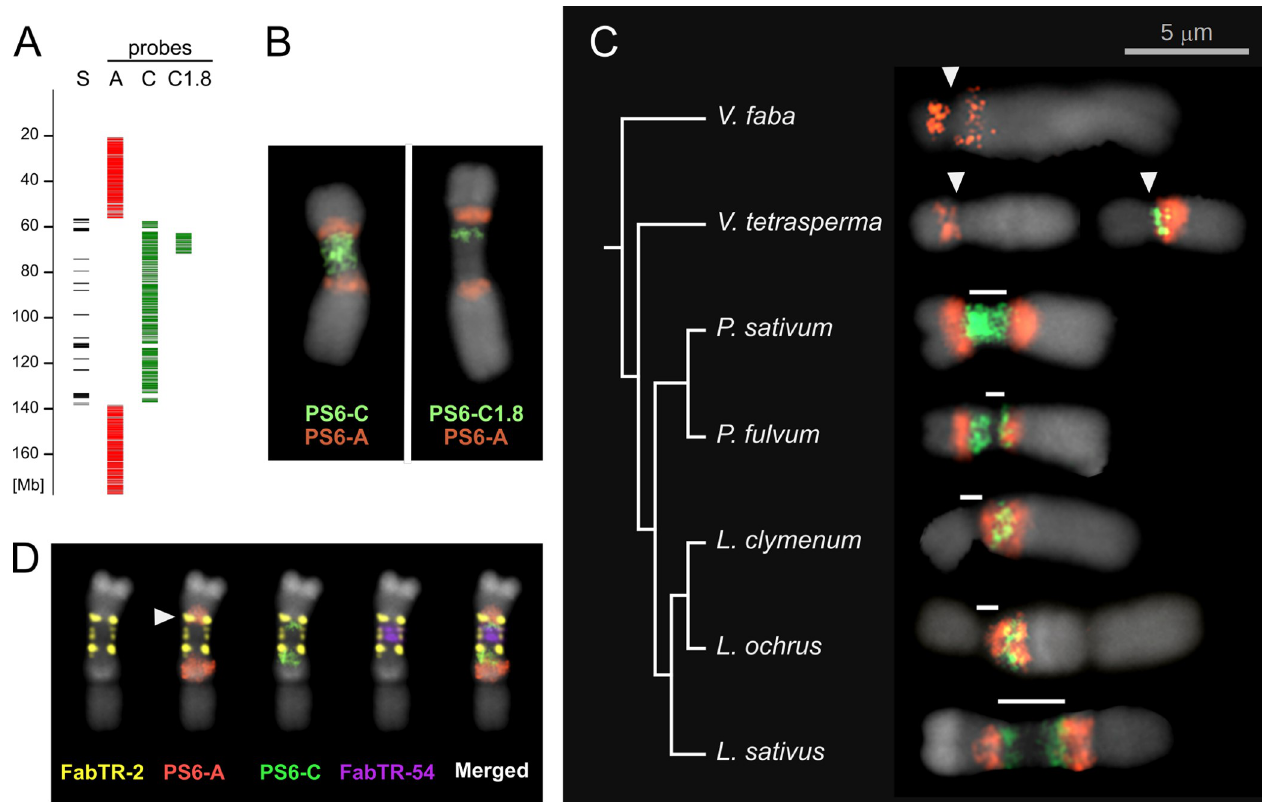
Fig 5. CEN6 painting probes and their application for the detection of orthologous regions in related species. (A) Positions in the assembly of oligonucleotide sequences used as FISH painting probes. Each column represents different PS6 probes. Column “S” shows the positions of satDNA arrays marking the extent of primary constriction. (B) Painting probes applied to P . sativum chromosome 6. (C) FISH analysis of a set of related Fabeae species using PS6-C (green) and PS6-A (red) probes. The phylogenetic tree was adapted from [20]. Only chromosome(s) that produced hybridization signals are shown. Primary constrictions are marked with white arrowheads (monocentric) or bars (metapolycentric chromosomes). Images of whole chromosome complements can be found in S5A Fig. (D) Multicolor FISH labeling of the Lathyrus sativus homeolog of pea chromosome 6 using PS6 painting probes as well as probes for satellite repeats FabTR-54, which fills the gap in the PS6-C signal, and FabTR-2, which is associated with CENH3 chromatin in L . sativus [20]. Arrowhead indicates the overlap of PS6-A and FabTR-2